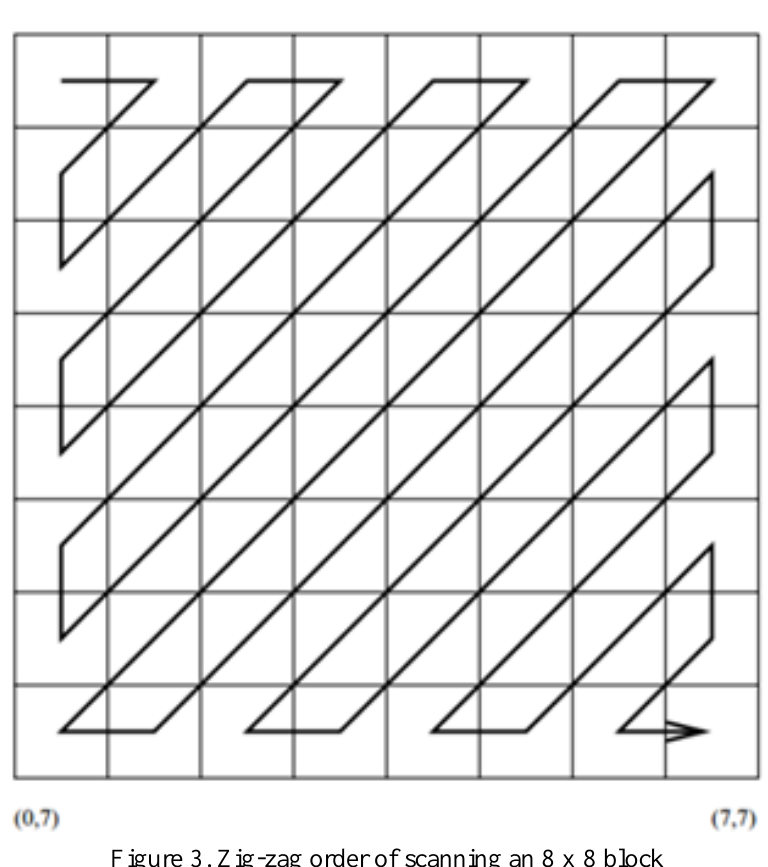
Figure 3. Zig-zag order of scanning an 8 x 8